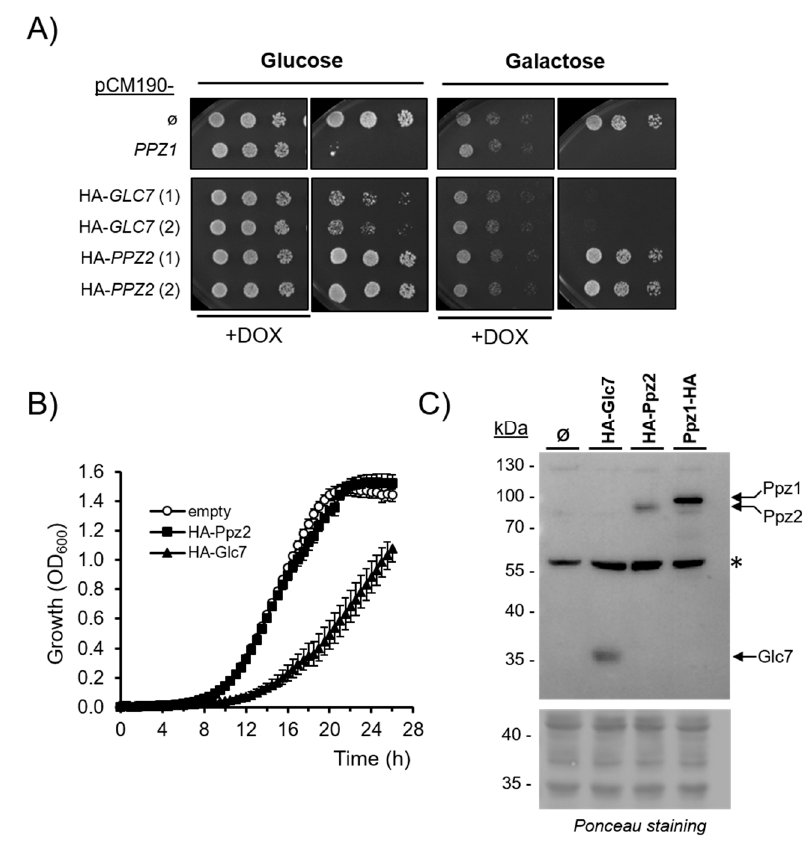
Figure 6. Effects on growth of expression of N-terminally-tagged Glc7 and Ppz2-phosphatases. ( A ) Wild type strain BY4741 was transformed with the indicated plasmids and spotted on plates containing the indicated carbon sources (2%). Ø, denotes the empty pCM190 plasmid. PPZ1 is an untagged version of the phosphatase. Plates were incubated for 3 days and all clones for a given condition were in the same plate. Numbers denote the clones tested. ( B ) Cells carrying the indicated plasmids were processed as in Figure 2B. Data are mean ± SEM of 4 − 6 determinations. ( C ) Protein extracts of BY4741 cells transformed with the indicated plasmids (clones 1 for Glc7 and Ppz2) were obtained as described in Materials and Methods. Cleared supernatants (500 ×g) were subjected to SDS-PAGE (40 µg of protein, 10% gels). After transfer to membranes, immunoreactive proteins were identified with anti-HA antibodies. The asterisk indicates a non-specific band recognized by the antibody. Ponceau staining of the membrane is shown in the lower panel.